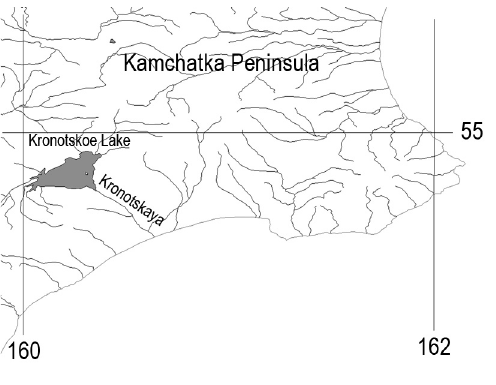
Fig. 23. Map of Sea Shore Tundra between Khodutka and Asacha Rivers calving